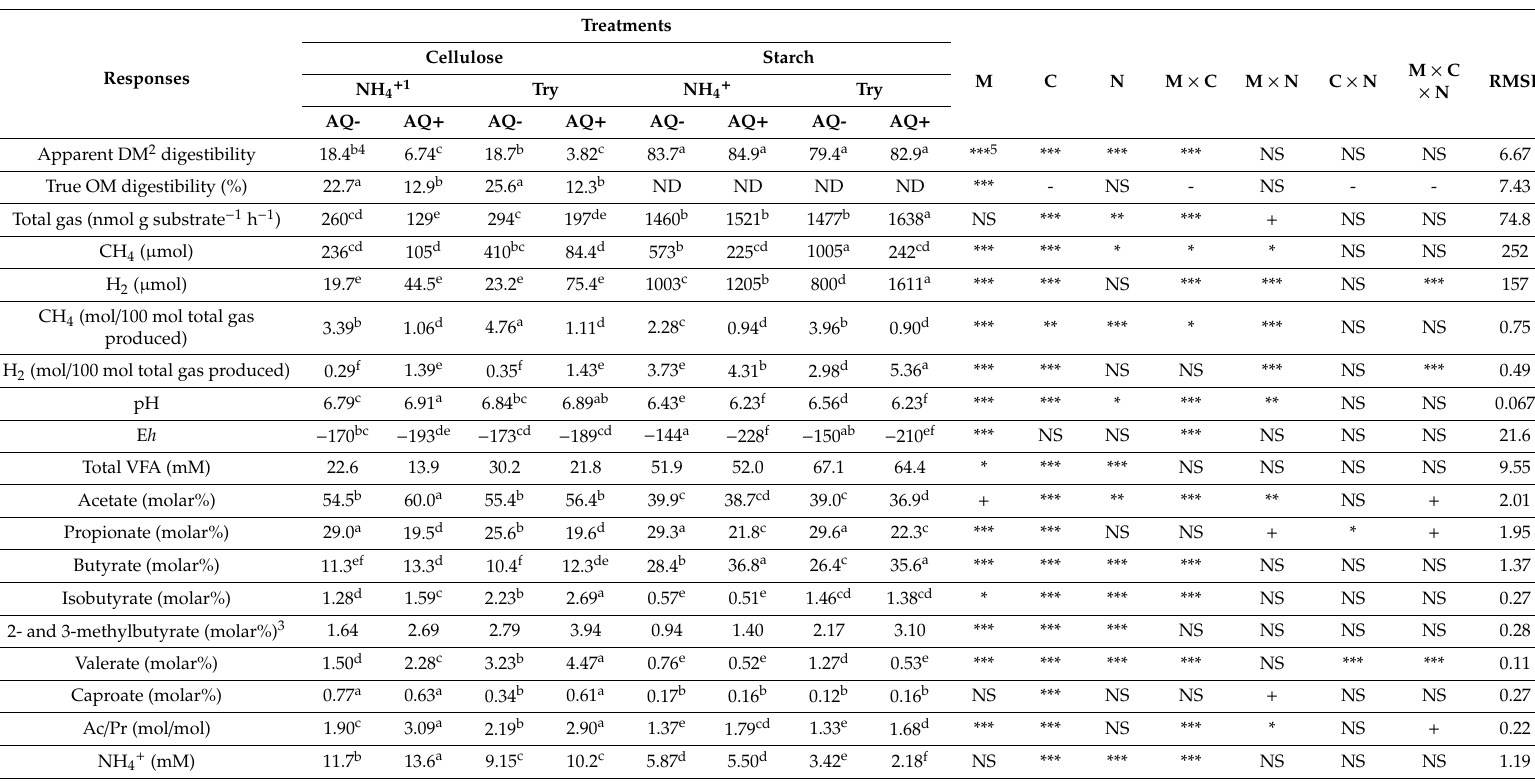
Table 1. E ff ects of the addition of 9, 10-anthraquinone to rumen batch cultures incubated with cellulose or starch as carbon and energy sources and ammonium or trypticase as nitrogen sources on digestion and fermentation